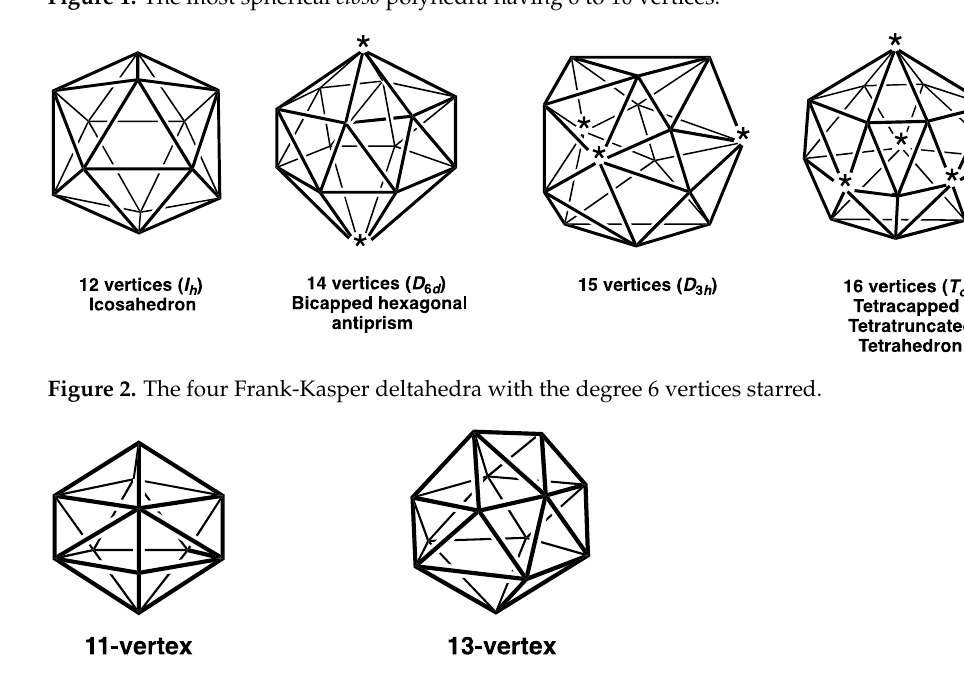
Figure 3. The 11- and 13-vertex closo Figure 2. The four Frank ‐ Kasper deltahedra with the degree 6 vertices starred. (5) For the 11 ‐ and 13 ‐ vertex systems the closo deltahedra are less symmetrical and nec ‐ essarily contain vertices of three different degrees, namely 4, 5, and 6 (Figure 3).